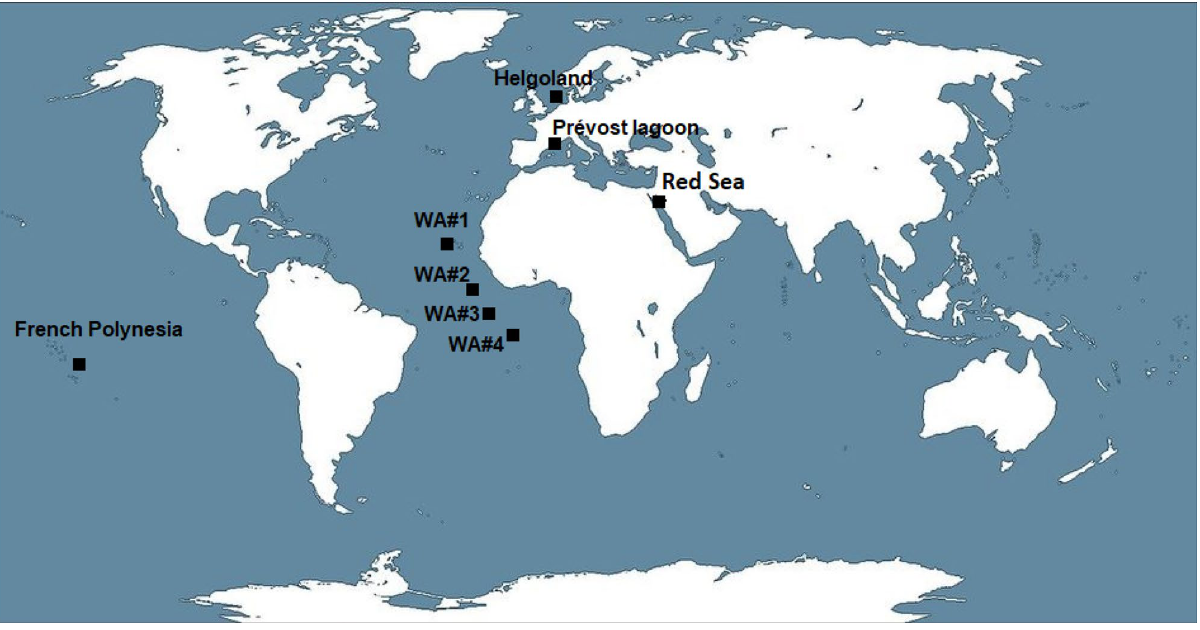
Figure 1. Map with the five sampling points. West African waters: WA1, WA2, WA3 and WA4. Helgoland: in front of Bremerhaven port-North Sea. Prévost Lagoon-Mediterranean Sea. Red Sea-Gulf of Aqaba. French